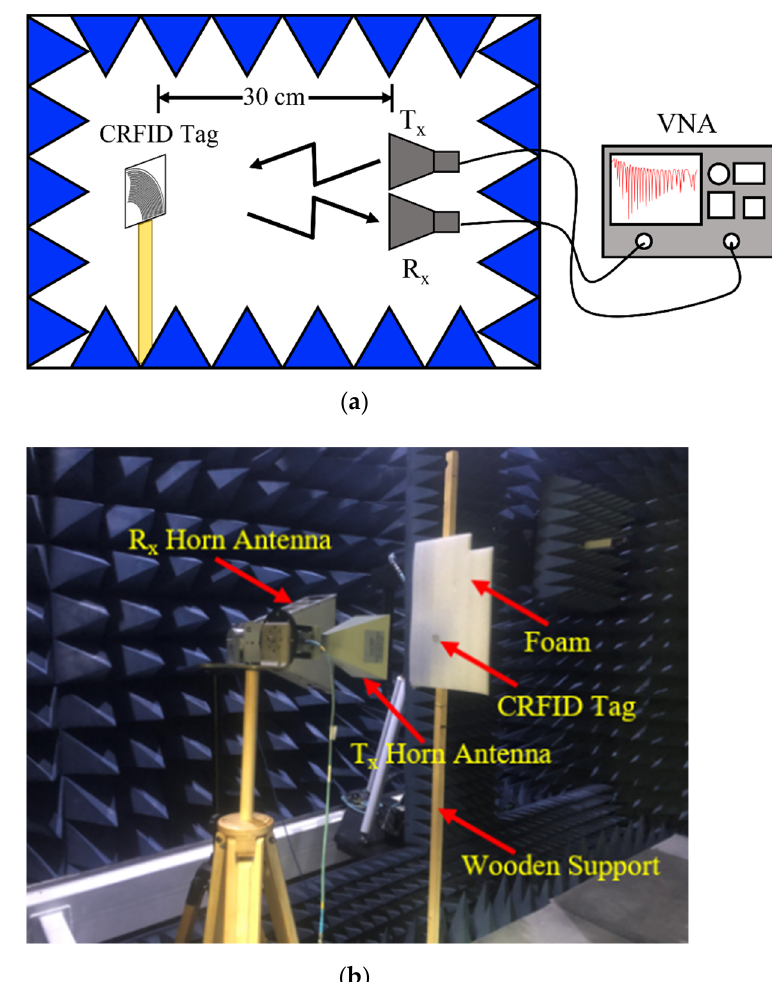
Figure 7. Measurement setup: ( a ) Schematic diagram; ( b ) Photograph of the measurement setup.